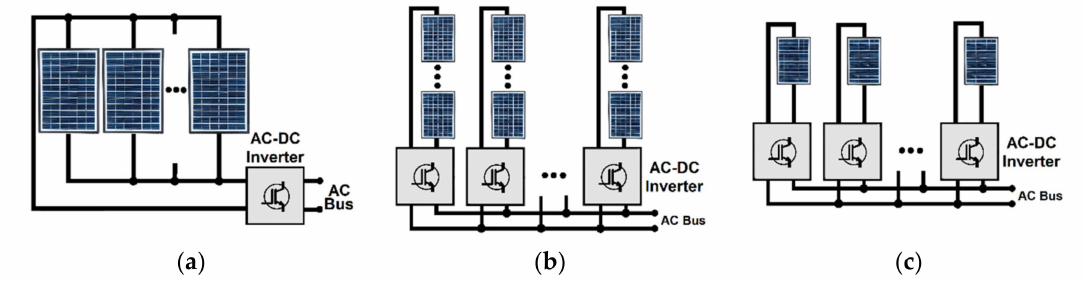
Figure 3. Conventional PV structures. ( a ) Centralized structure; ( b ) string structure; ( c ) module structure